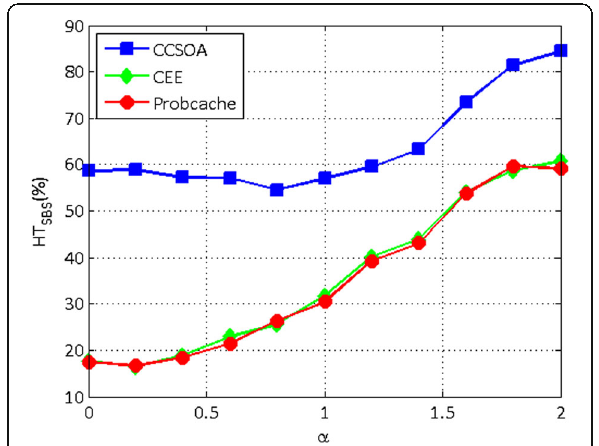
Fig. 22 Impact of Γ to ACO in the SBS level in ER model with different α ( d UE ¼ 4 ; N UE ¼ 60 ; T SBS